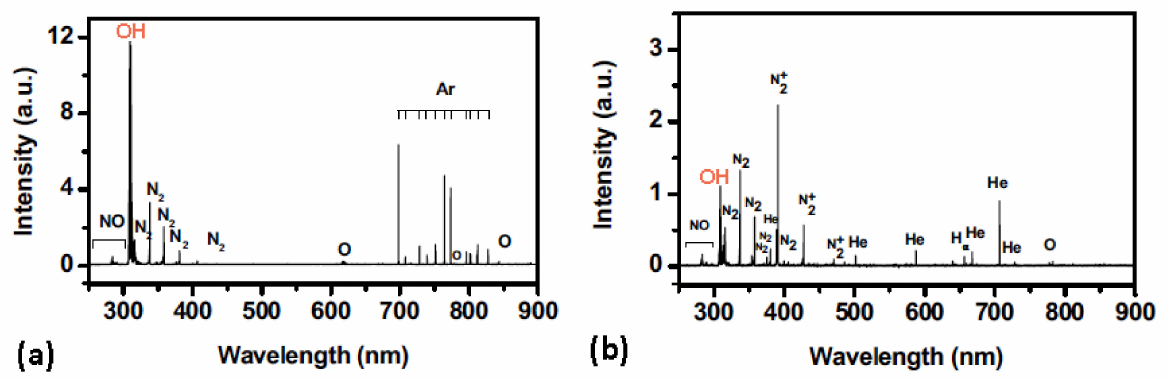
Figure 5. Emission spectra of: ( a ) Ar pulsed 2 kV plasma, and ( b ) He pulsed 2 kV plasma showing the presence of a significant amount of OH and N 2 species. Reprinted with permission from [30] (Park et al.). Copyright 2021 American Institute of